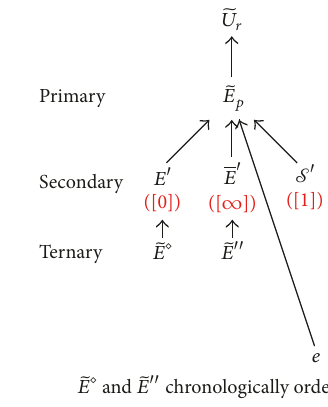
̃ E ch with the event 𝑒